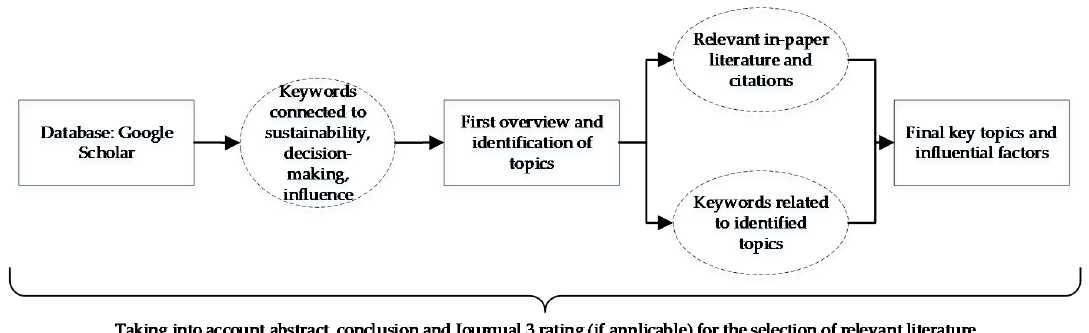
Figure 1. Methodology of the literature search and identification of influential factors.